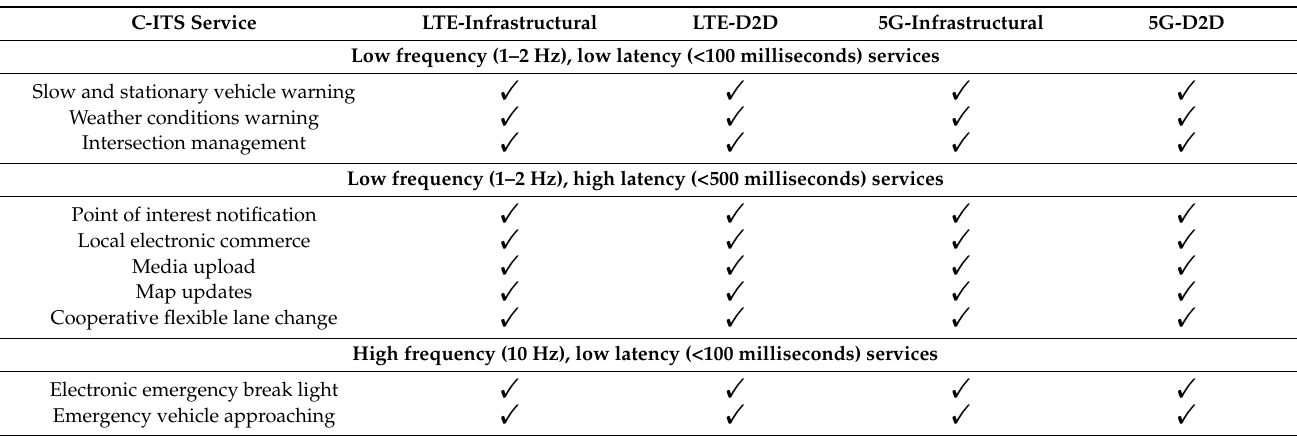
Table 4. Communication requirements of common Cooperative Intelligent Transport Systems (C-ITS) services and their fulfillment by the investigated communication technologies in the investigated context. Adapted from [39] and